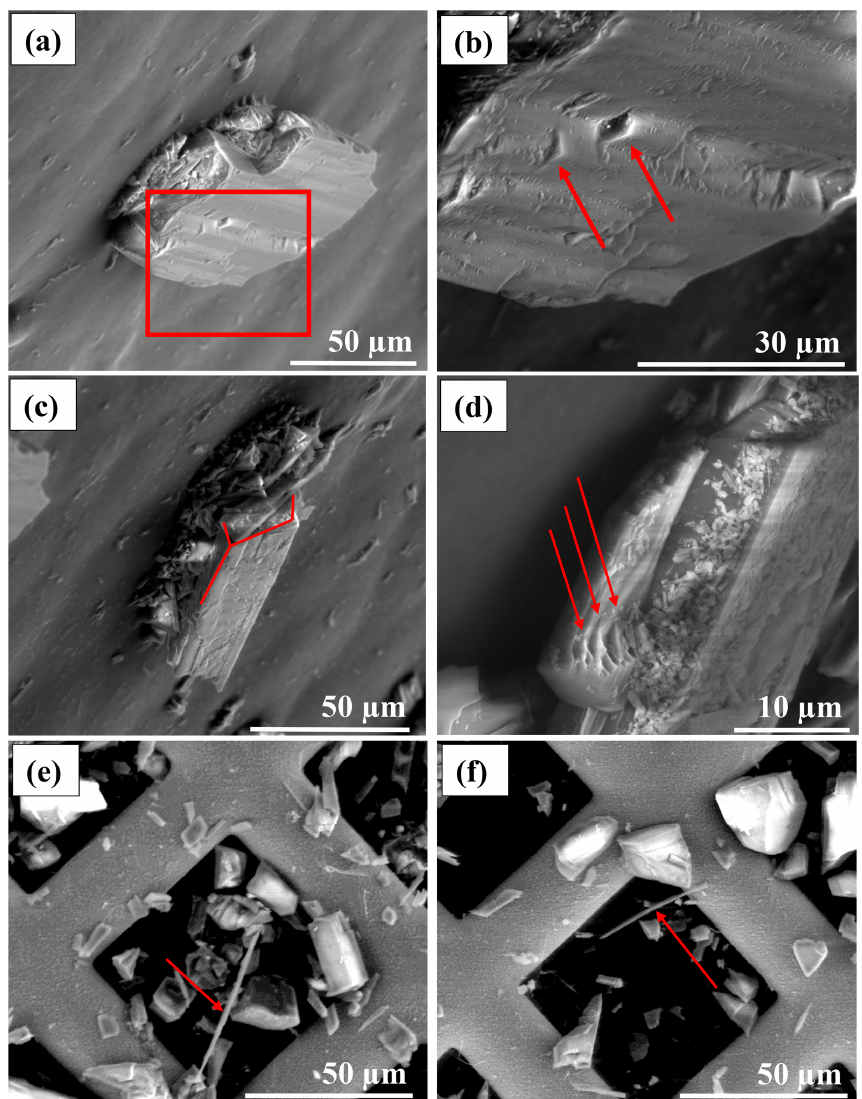
Figure 9. Glaucophane particle morphology observed on a 70 ◦ inclined SEM stub. (a) Stepped glaucophane particle. The red square rep- resents a region of interest (ROI) shown in greater detail in panel (b) . (b) Stepped structure with slightly rounded edges. (c) An elongate prismatic particle in which the characteristic amphibole angles are visible (56 ◦ and 124 ◦ ). (d) Lamellar structures (red arrows) with rounded and sharp edges. (e, f) SEM picture of a TEM grid showing the presence of large fibrous particles (red